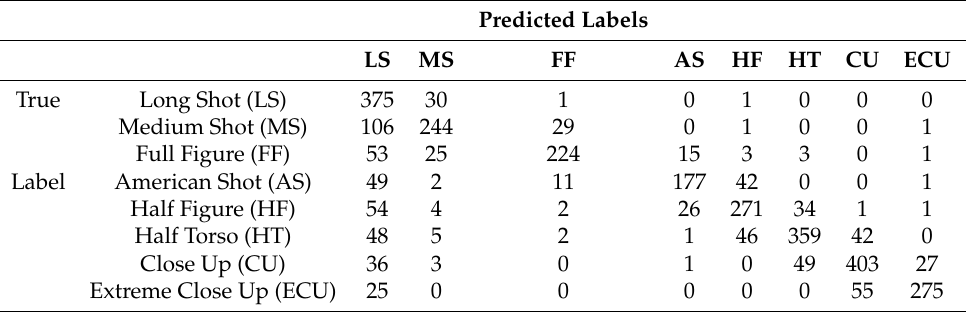
Table 17. Confusion Matrix of random forest trained on predictions.